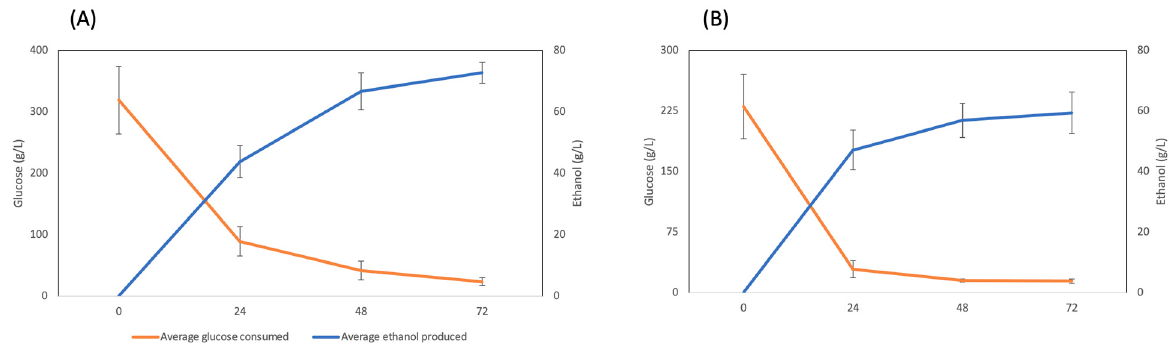
Figure 4. Average consumption of glucose and average production of ethanol by Saccharomyces cerevisiae fermentations of barley ( A ) and oats ( B ).